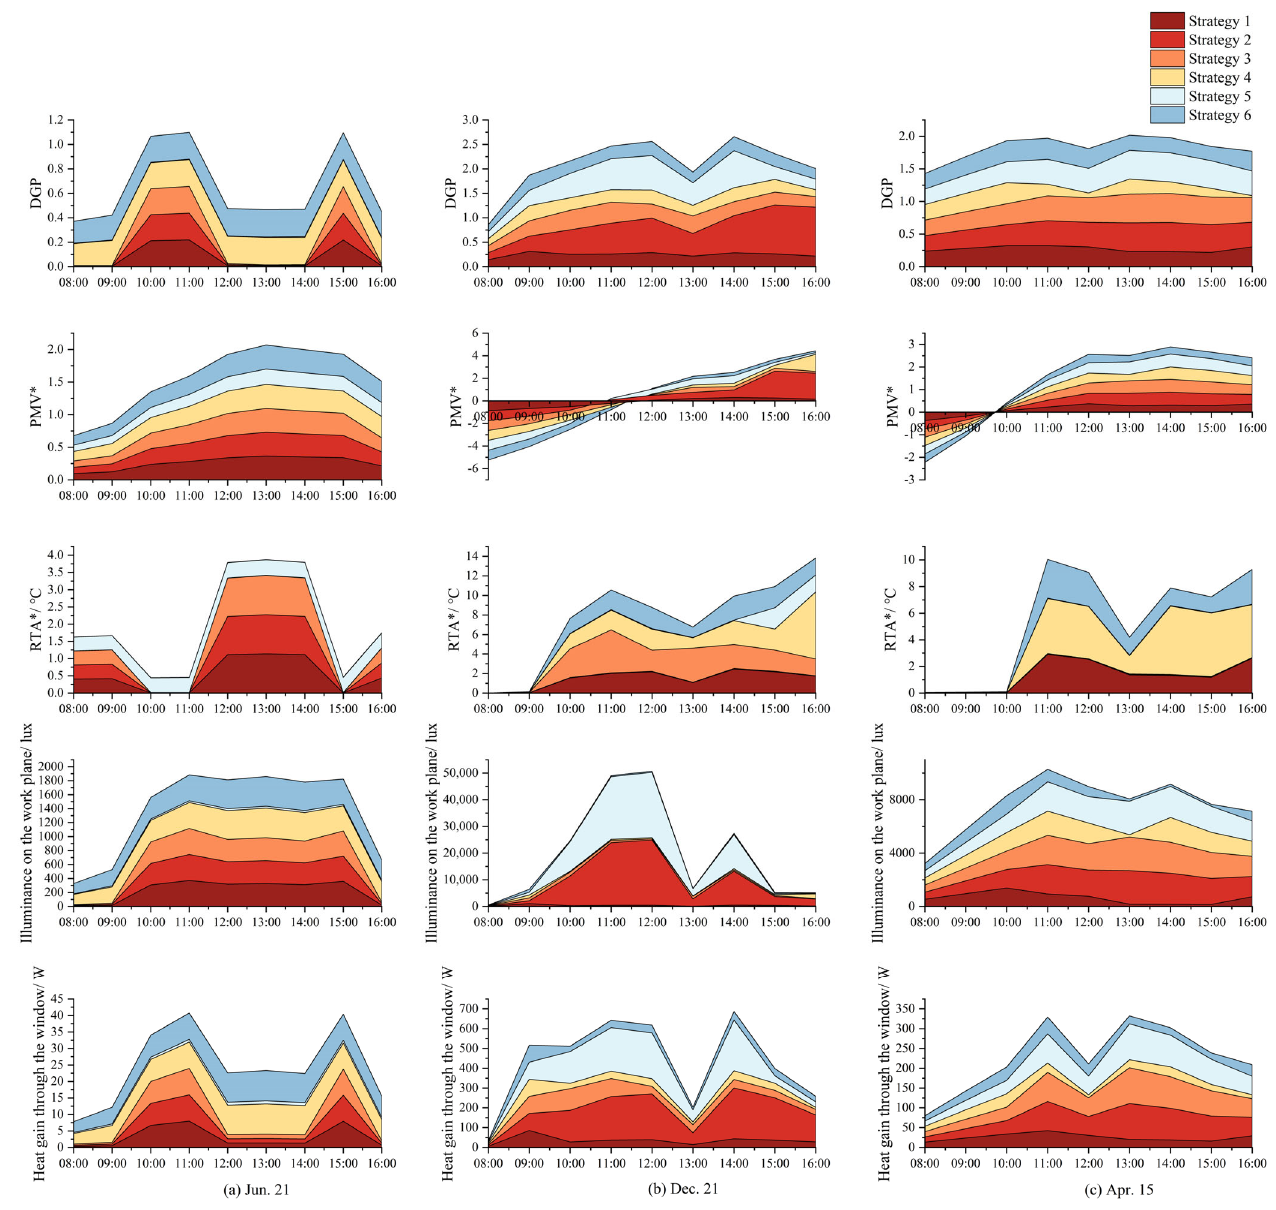
Figure 10. Index accumulation chart of three typical days in case 2.